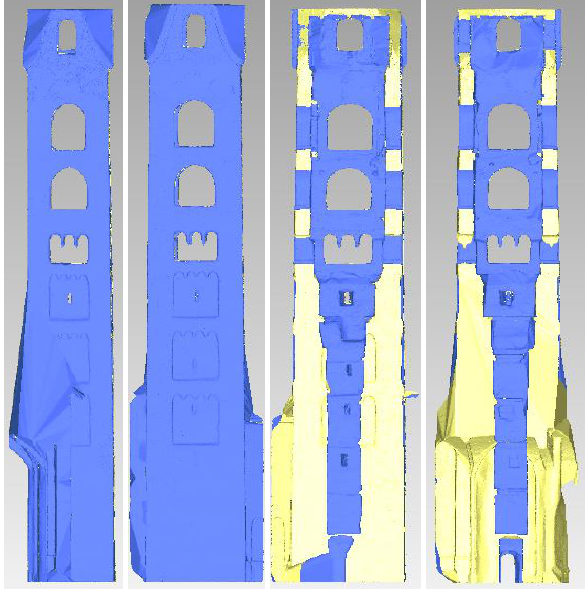
Figure 8. Corrected polygonal model of the external part. From left: West front, Northeast front, section of Southeast front and section of South front.